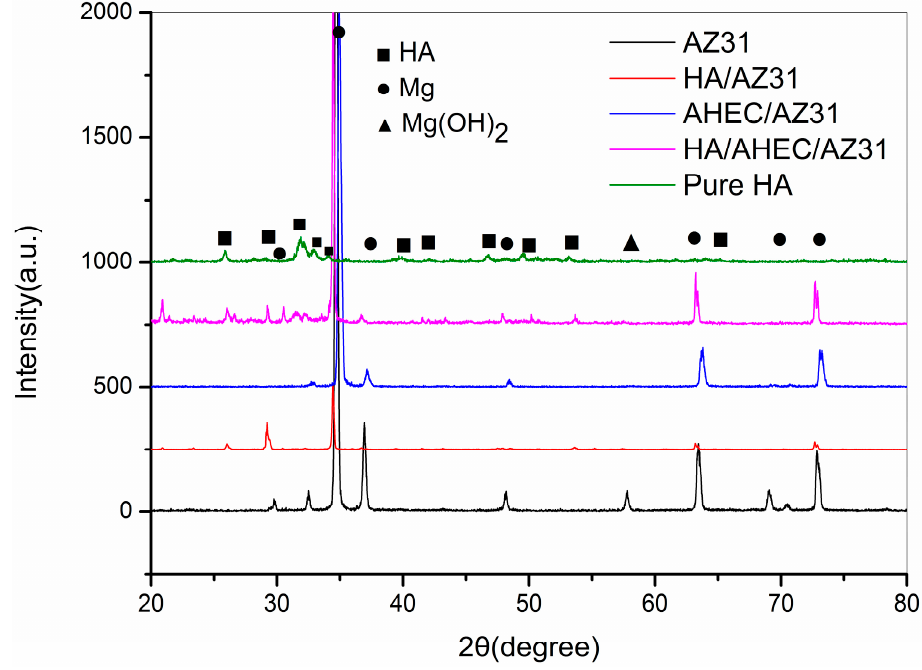
Figure 2. X-ray diffractometer (XRD) pattern of AZ31, HA/AZ31, AHEC/AZ31, HA/AHEC/AZ31, and Pure HA specimens.